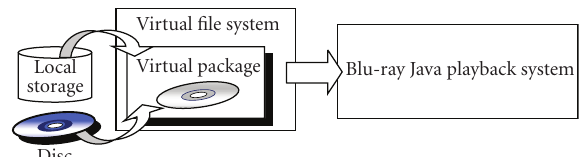
Figure 4: Simplified view of the Blu-ray playback system